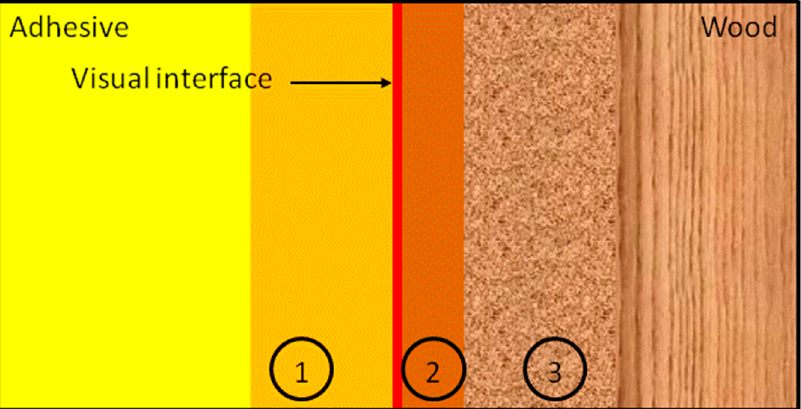
Figure 10. Schematic representation of the interfacial zone between adhesive and wood. 1: adhesive boundary layer, 2: interface between boundary layer and wood substrate which constitutes the adhesion mechanism (mechanical interlocking, covalent bonding, or secondary chemical bonds), and 3: adhesive penetration zone.